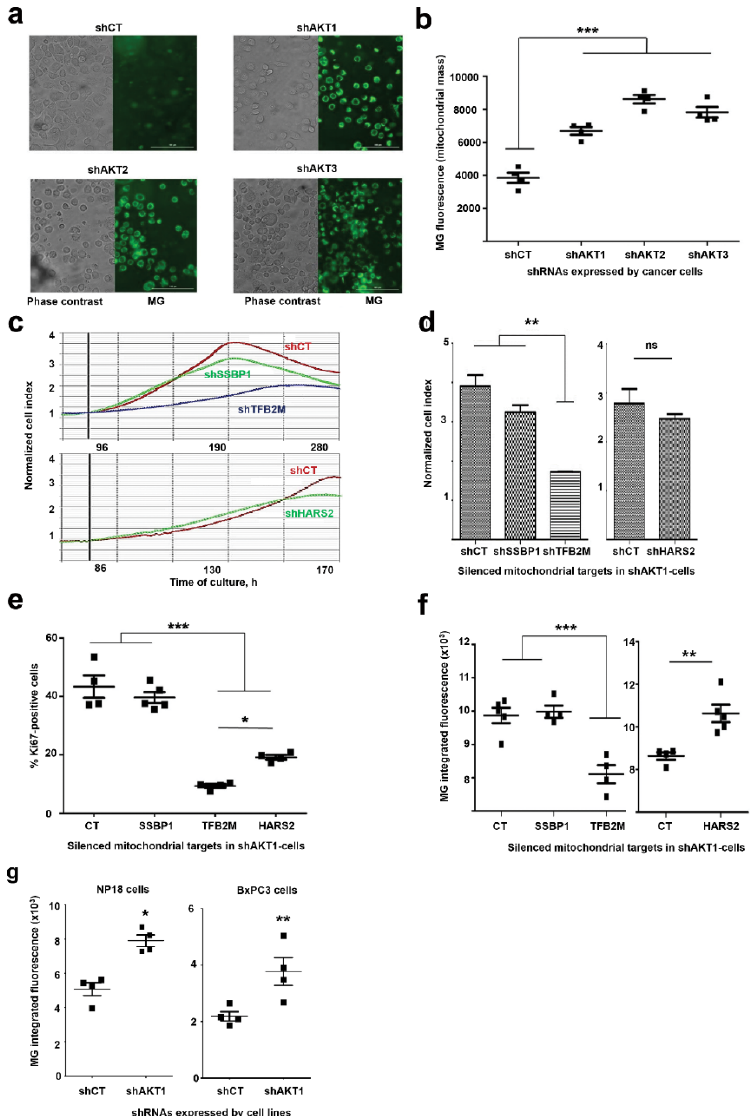
Figure 3. Increased mitochondrial content in cells required for adaptation to AKT silencing. ( a ) Phase contrast and fluorescent microscopy pictures of MitoTracker Green (MG)-stained cancer cell lines adapted to silencing of the indicated AKT isoforms. The control cell line was overexposed to detect background fluorescence signal. Bars within the pictures represent 100 µm. ( b ) Dot plot representing integrated fluorescence intensities, using four biological replicates per cell line. Means and standard deviations are also shown. Relevant statistical comparisons are shown by ANOVA and Tukey’s pairwise tests. ( c ) RTCA graphs representing the growth of cells with silenced AKT1 and additional silencing of the indicated mitochondrial proteins. Data are shown with means from duplicate cultures together with error bars. ( d ) Column graphs plotting the Normalized Cell Index from RTCA data corresponding to the left RTCA graphs. Relevant statistical comparisons are shown in the graph by ANOVA and pair-wise comparisons (Tukey´s test). ( e ) Scatter plot of KI-67 expression by flow cytometry for the indicated cell lines. Relevant statistical comparisons are shown within the graph by ANOVA and Tukey’s pairwise tests. ( f ) Scatter plots of integrated MG fluorescence intensity for the indicated cell lines. Data from five replicates are shown, with means and error bars (standard deviations). ( g ) Scatter plots of integrated MG fluorescence intensity for the indicated cell lines. Data from four replicates are shown, with means and error bars (standard deviations). *, **, ***, indicate significant ( p < 0.05), very significant ( p < 0.01) and highly significant ( p < 0.001) differences.